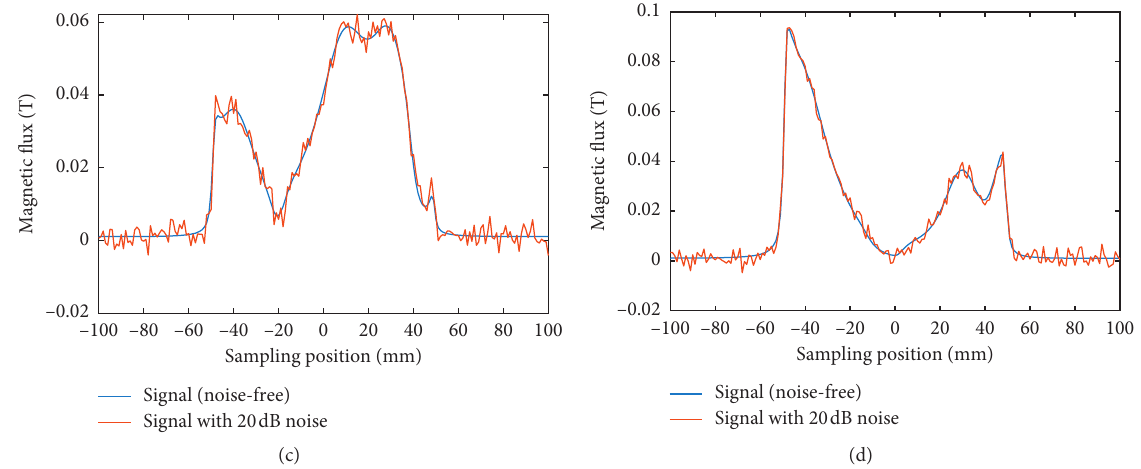
Figure 11: Signal used to get the results in Figure 10, including the contaminated signal and corresponding noise-free signal. (a) 10% ranking. (b) 30% ranking. (c) 70% ranking. (d) 90% ranking.